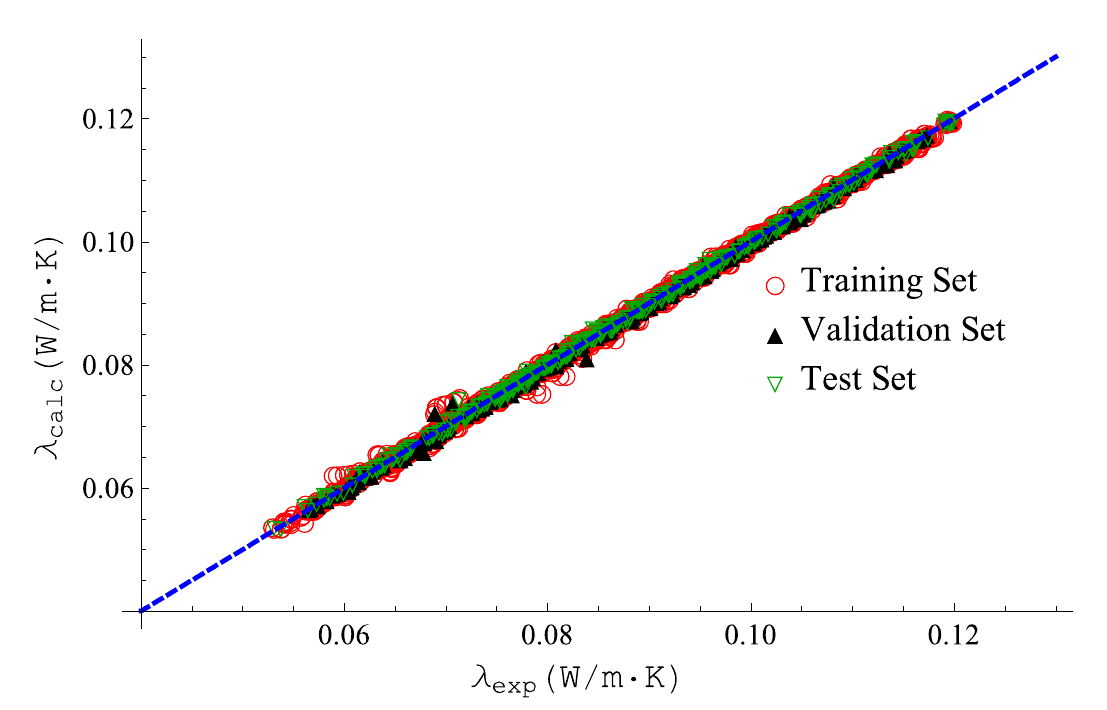
Figure 4. Correlation between the experimental and the corresponding calculated thermal conductivity data divided into the training, validation, and test sets.